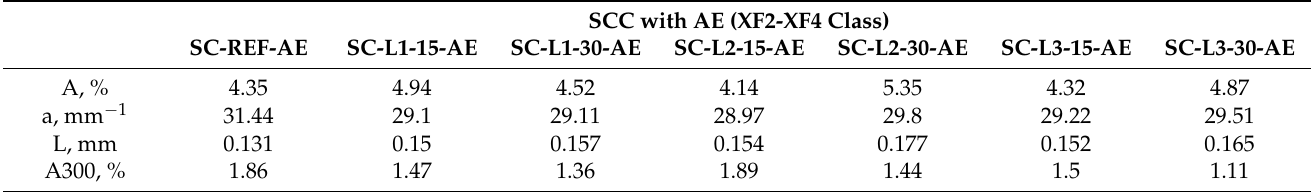
Table 7. Air void distribution parameters for self-compacting air-entrained